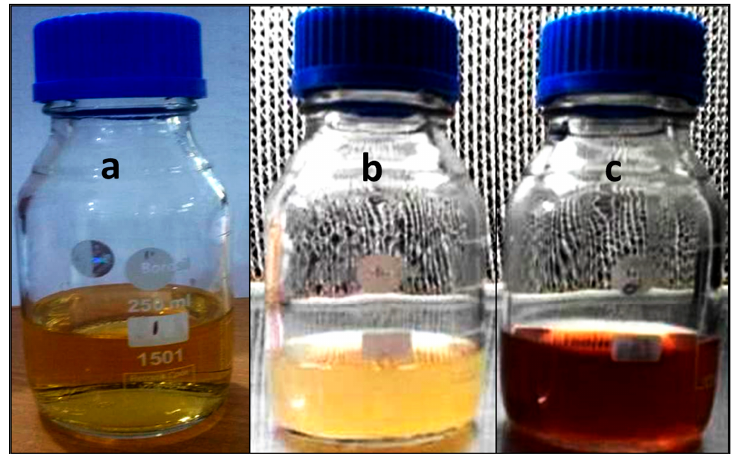
Figure 1. Biosynthesis of AgNPs using an extracellular filtrate of C. glabrata after 12 h at room temperature in dark conditions. ( a ) Sterile Sabouraud dextrose broth with AgNO 3 ; ( b ) Cell filtrate without AgNO 3 ; ( c ) Cell filtrate with AgNO 3.